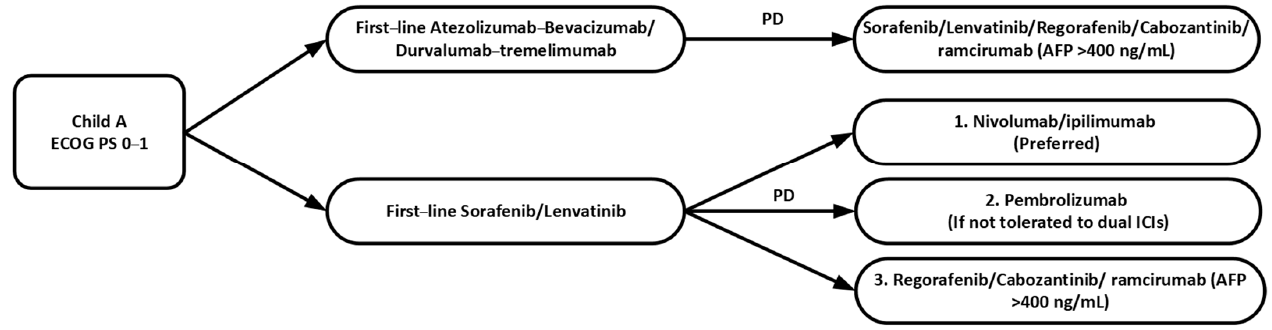
Figure 2. Sequence of second-line systemic therapy in advanced HCC. ECOG PS: Eastern Cooperative Oncology Group Performance Status; ICIs: immune checkpoint inhibitors; PD: disease progression.